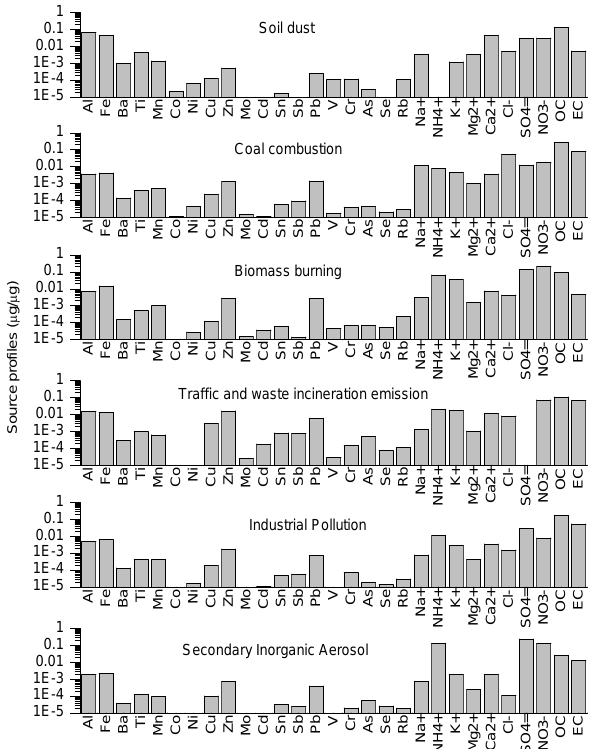
Figure 8 Fig. 8. Profiles of six sources identified from the PMF model, in- cluding soil dust, coal combustion, biomass burning, traffic and waste incineration emission, industrial pollution, and secondary in- organic aerosol (from the upper to the lower